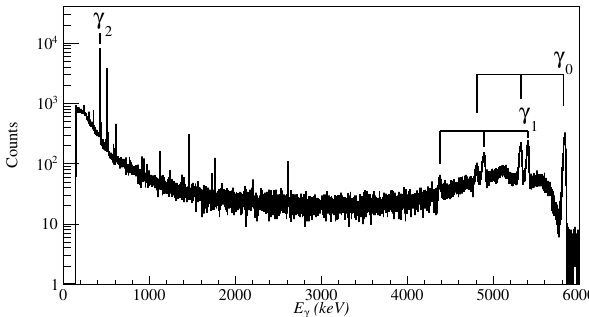
Figure 2. Experimental γ spectrum acquired at E p = 265 keV. The 6 Li(p, γ ) 7 Be proceeds through direct capture (DC) to either the ground state of 7 Be, γ 0 , or its first excited state, γ 1 , with subsequent emission of a 429 keV secondary gamma ray, γ 2